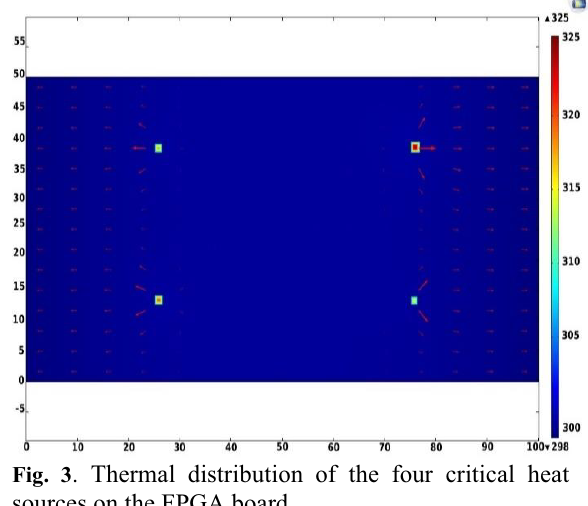
Fig. 3 . Thermal distribution of the four critical heat sources on the FPGA board.